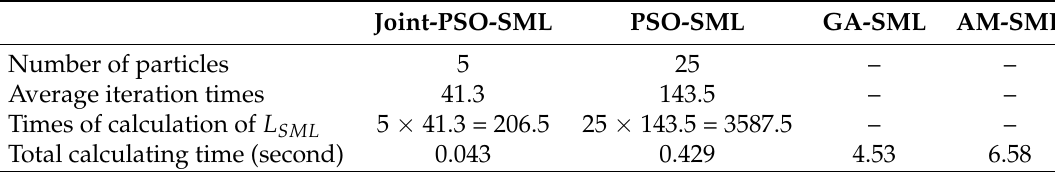
Table 8. Comparison of computational complexity of Joint-PSO, PSO, GA and AM for SML. Scenario: p = 8, q = 4, r = 4, N = 100, SNR = 0 dB, The ture DOA: 10 ◦ , 20 ◦ , 30 ◦ and 40 ◦ (4 sources), 30 independent trials, RMSE =